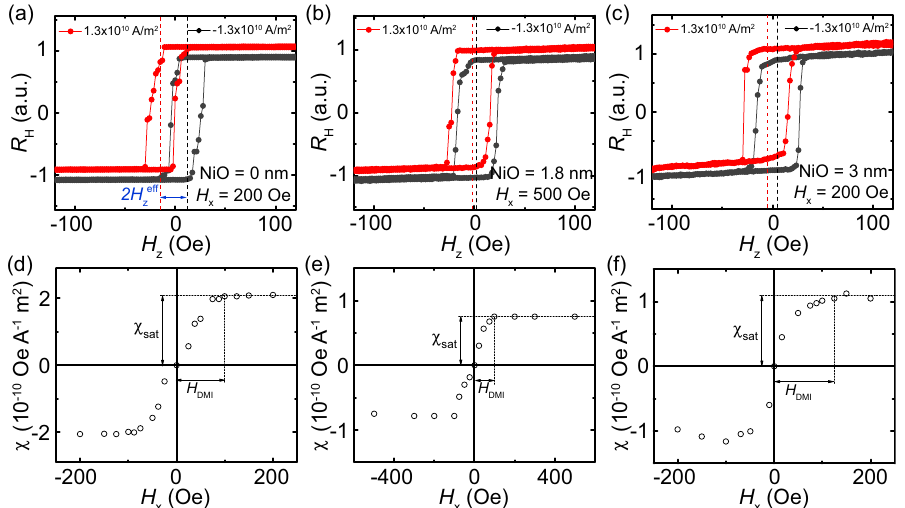
Figure 3. AHE resistance curves of the Pt (4 nm)/NiO ( t nm)/TmIG (4 nm) devices by sweeping H z with ( a ) t = 0 nm and H x = 200 Oe, ( b ) t = 1.8 nm and H x = 500 Oe, ( c ) t = 3 nm and H x = 200 Oe. Slight vertical offsets for both AHE loops are introduced for clarity. Corresponding H x dependence of the SOT efficiency χ for ( d ) t = 0 nm, ( e ) t = 1.8 nm and ( f ) t = 3 nm. χ sat is the maximum SOT efficiency, and H DMI is the field that χ